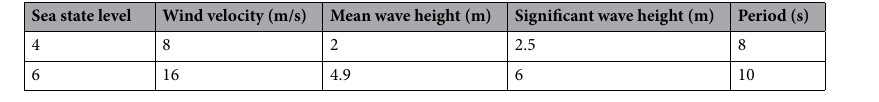
Table 1. Sea state parameters of deep sea